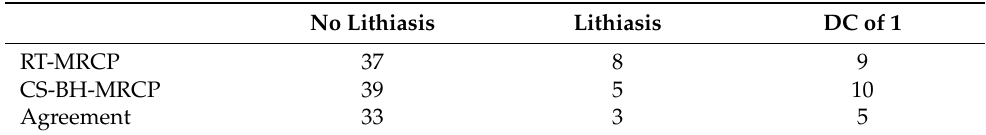
Table A6. Common bile duct lithiasis detection based on the consensus between the two readers: Number of patients ( n = 54) with or without visible lithiasis on RT-MRCP and CS-BH-MRCP images (only for images with confidence diagnostic of 2 or 3).